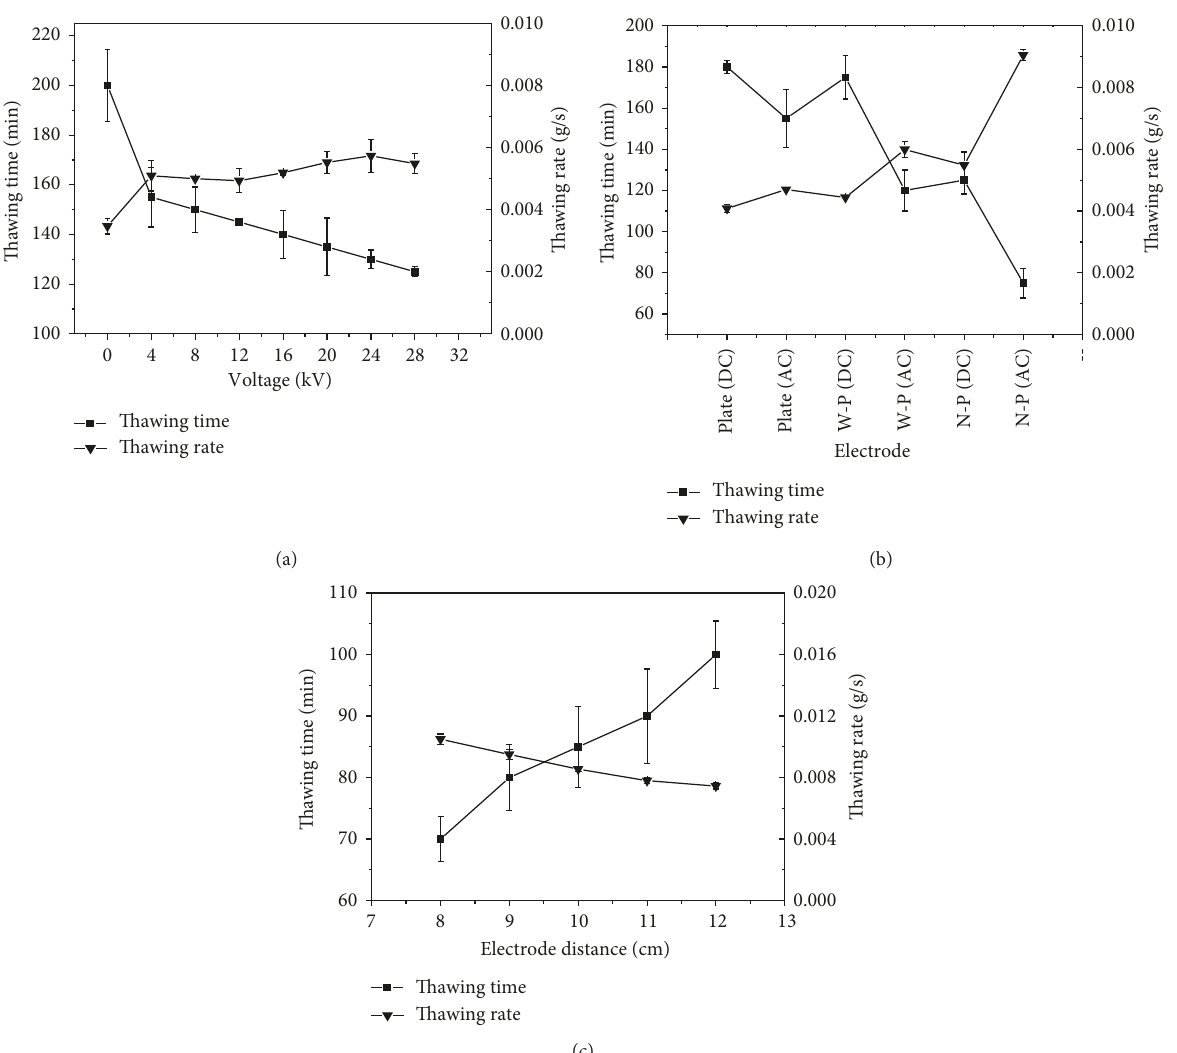
Figure 2: (a) Thawing time and thawing rate of frozen tofu in different voltages. The frozen tofu was thawed at 20 ° C with a fixed discharge gap of 100mm under DC electric field. The thawing voltage was 0kV (the control samples), 4kV, 8kV, 12 kV, 16kV, 20kV, 24 kV, or 28kV, respectively.(b) Thawing time and thawing rate of frozen tofu in different electrodes. Plate (DC): the plate-to-plate electrodes under DC electric field, plate (AC): the plate-to-plate electrodes under AC electric field, W-P (DC): the wires-to-plate electrodes under DC electric field, W-P(AC): the wires-to-plate electrodes under AC electric field, N-P(DC): the needles-to-plate electrodes under DC electric field, and N-P(AC): the needles-to-plate electrodes under AC electric field. The corresponding discharge gap between the high-voltage electrodes and the grounded electrode was 100mm. The corresponding voltage was 28kV (c) Thawing time and thawing rate of frozen tofu in different electrode distances. The discharge gap was 8cm, 9cm, 10cm, 11cm, and 12cm with multiple needles-to-plate electrode for AC electric field, respectively. The corresponding voltage was